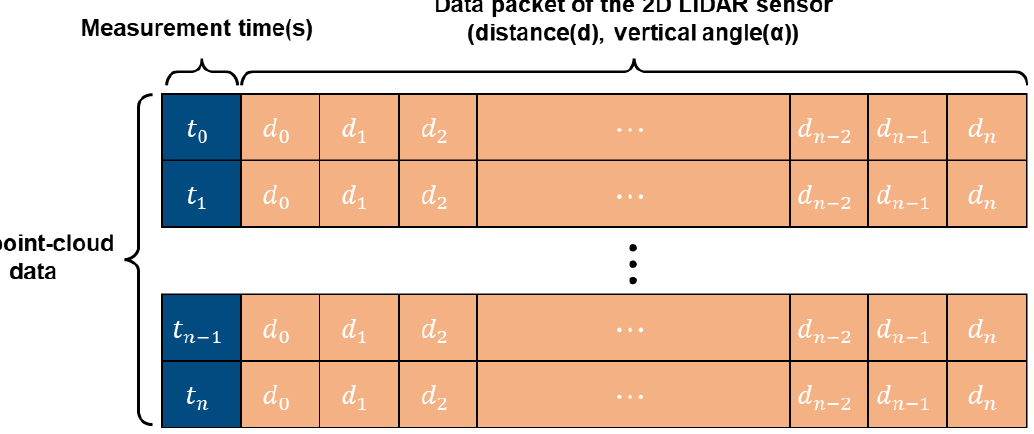
Figure 8. Structure of the 3D point cloud data collected by the hardware.